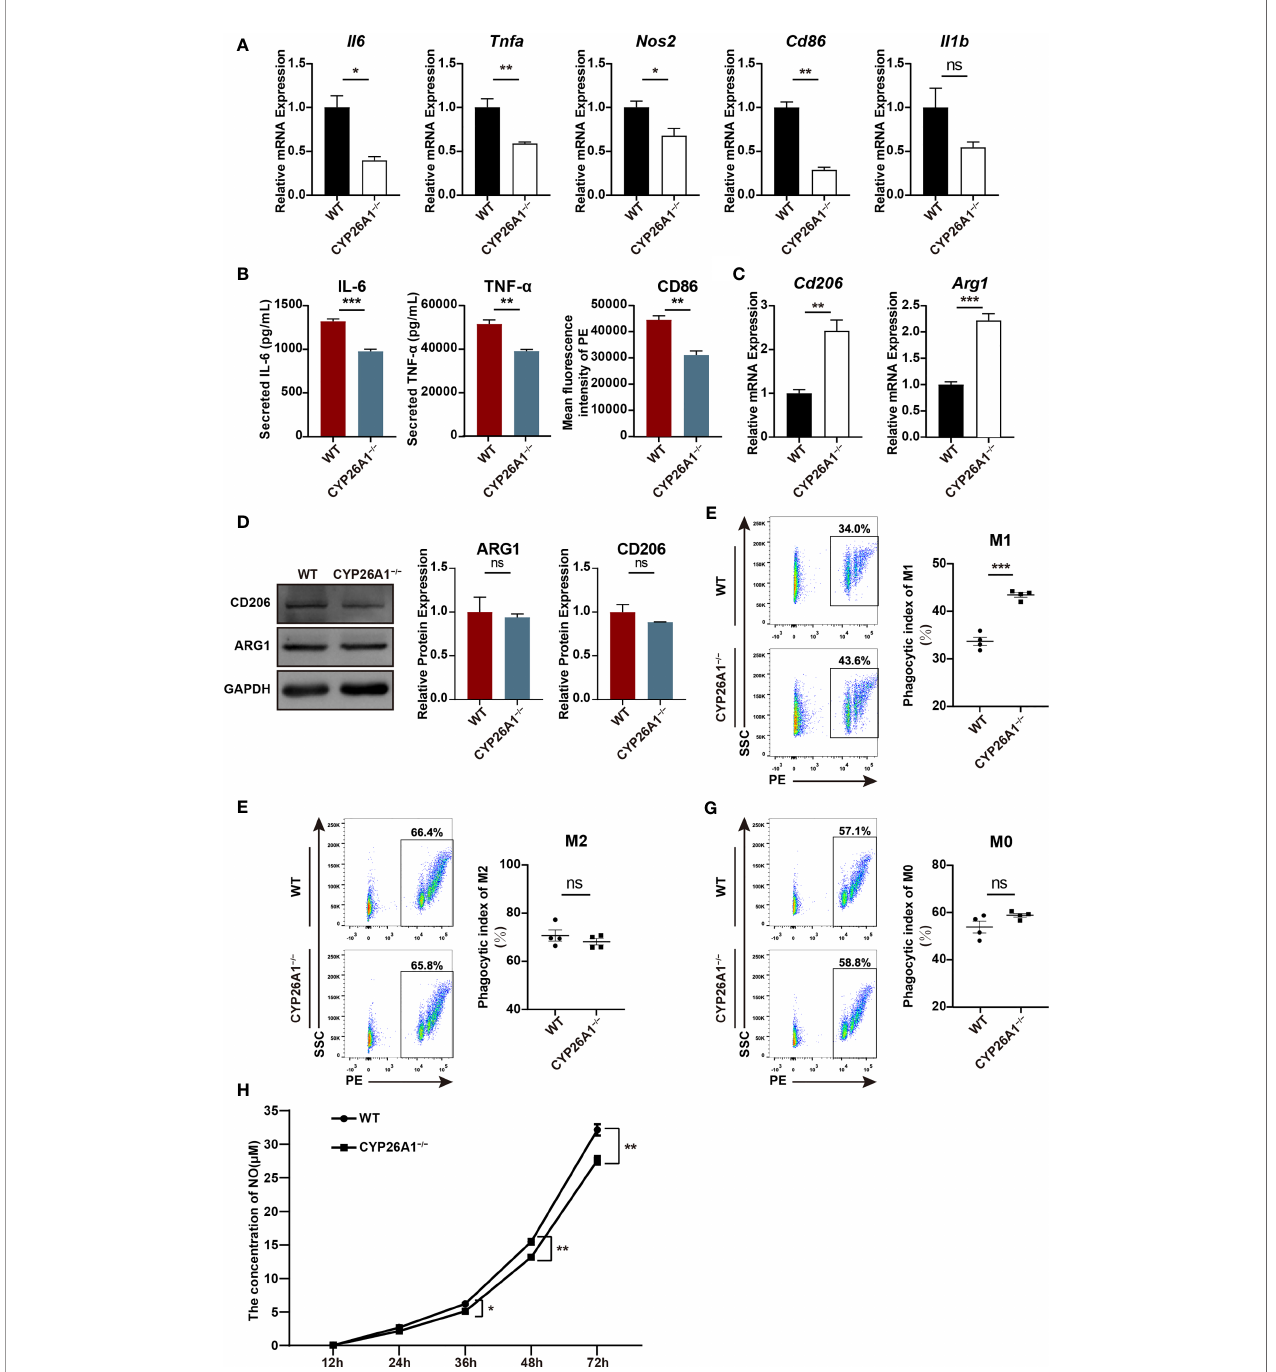
FIGURE 5 | CYP26A1 de fi ciency affected the polarization, phagocytic capacity and NO production capacity of Raw264.7 cells. (A) qPCR analysis of M1 phenotype genes Il6 , Nos2 , Tnfa , Cd86 and Il1b in CYP26A1-de fi cient Raw264.7 and WT cells after induced 4 h by LPS and IFN- g (n=3). (B) ELISA was used to measure IL-6 and TNF- a secretion in supernatants of Raw264.7 cells (WT and CYP26A1 − / − ) treated with LPS and IFN- g for 24 h; Mean fl uorescence intensity analysis of CD86 expression levels in Raw264.7 cells (WT and CYP26A1 − / − ) incubation with LPS and IFN- g for 24 h (n=3). (C) qPCR analysis of M2 markers Arg1 and Cd206 in CYP26A1 knockout Raw264.7 and WT group after induced 4 h by IL-4 and IL-13 (n=3). (D) Western blot analysis of M2 markers ARG1 and CD206 in CYP26A1 knockout Raw264.7 and WT group after induced 24 h by IL-4 and IL-13 (n=3). GAPDH was used as loading control. (E – G) Flow cytometry analysis of the phagocytic capacity of Raw264.7 (WT and CYP26A1 − / − ) under M0, M1 and M2 state (n=4). (H) The concentration of NO in the supernatant of RAW264.7 cells (WT and CYP26A1 − / − ) treated with LPS and IFN- g at different induction time (12 h, 24 h, 36 h, 48 h, 72 h) was detected by griess reagent (n=4). Error bars represent means ± SEM; two-tailed unpaired t-test, ns, not signi fi cant, *P < 0.05, **P < 0.01, or ***P <